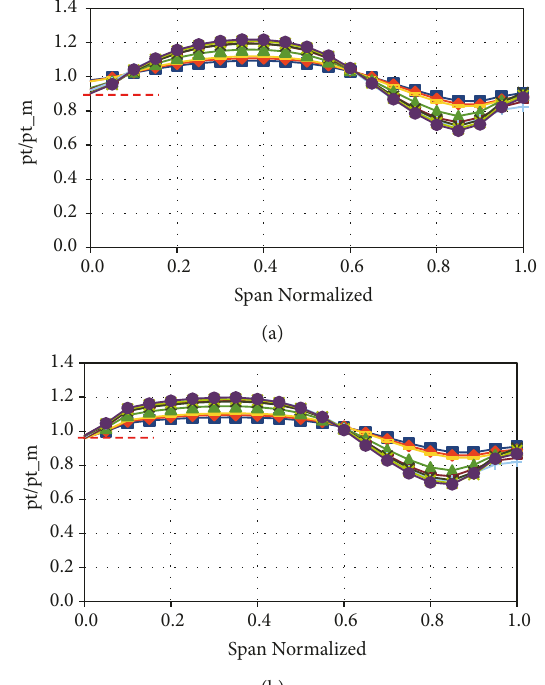
(b) Figure 23: Total pressure ratio vs span, partial hub admission, (a) with cavity and (b) without